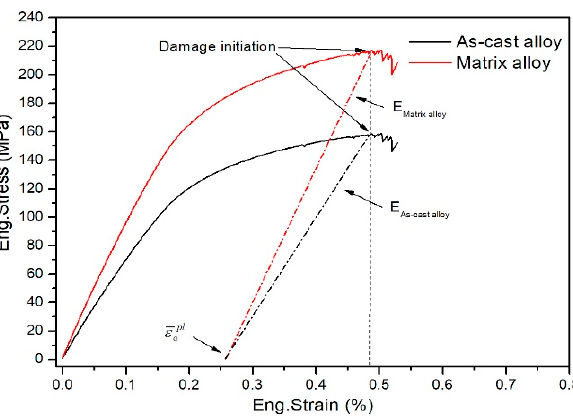
Figure 4. Tensile stress ‒ strain curves of the as-cast alloy and the matrix alloy.